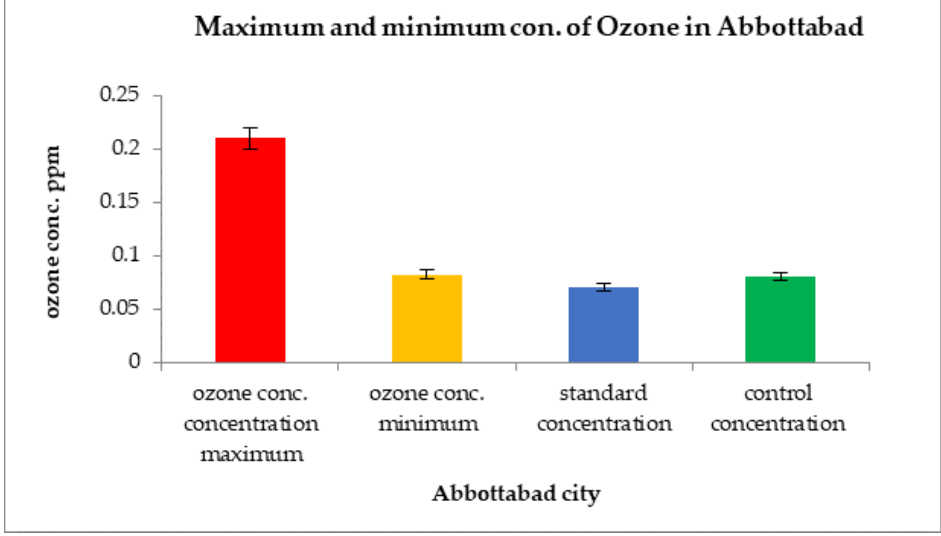
Figure 12. Comparison of maximum and minimum ozone concentrations with control sites and WHO standard values in Abbottabad.